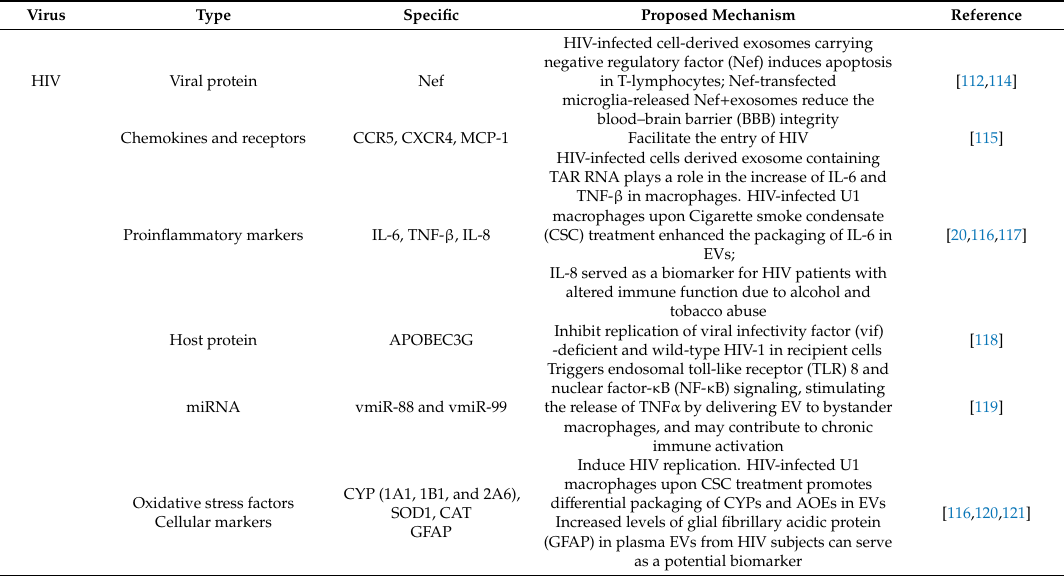
Table 1. Role of extracellular vesicles in viral pathogenesis and